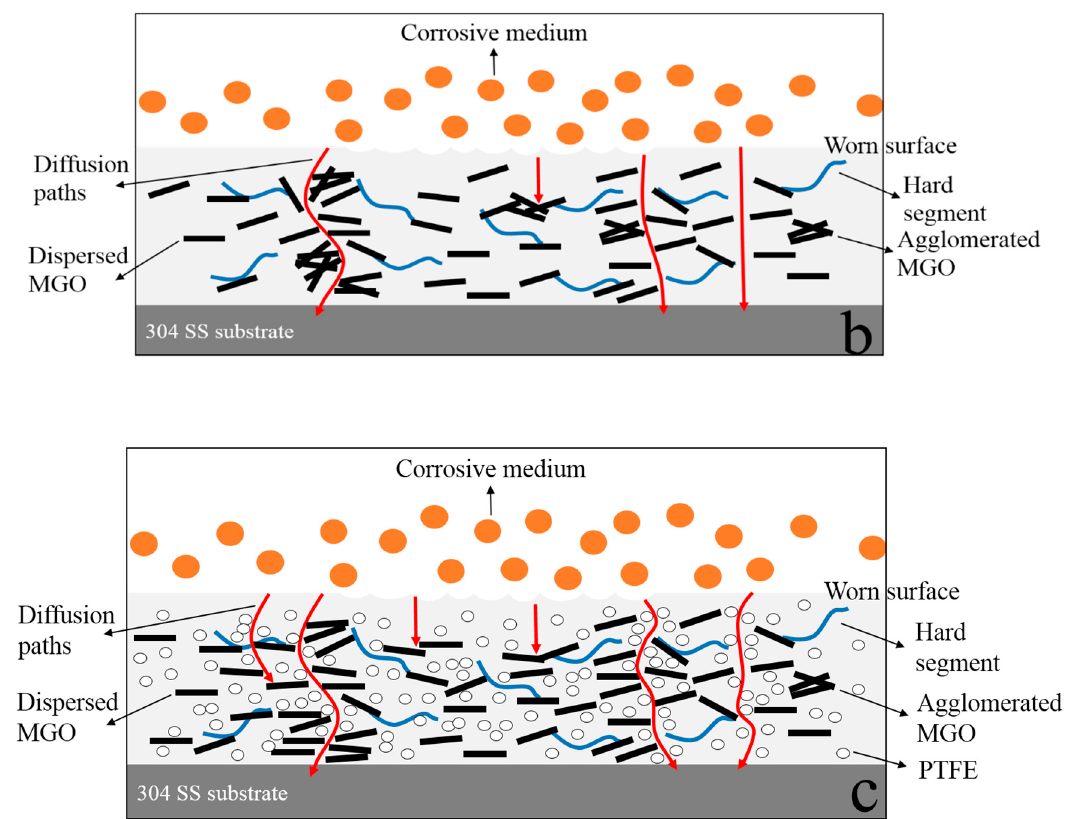
Figure 13. The anticorrosion mechanism for the worn pure WPU coating ( a ), the worn MGO/WPU composite coating ( b ) and the worn MGO-PTFE/WPU composite coating ( c ).